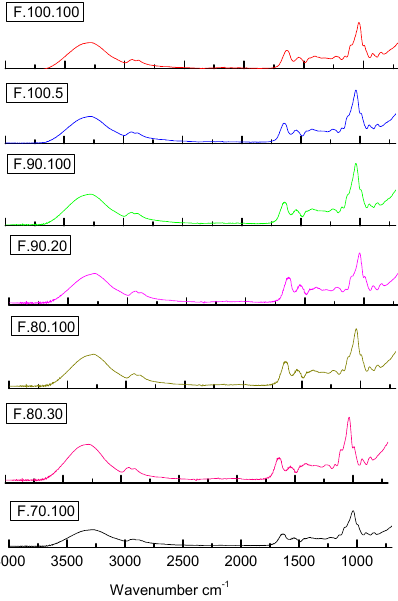
Figure 1. FTIR spectra of the kefiran films.